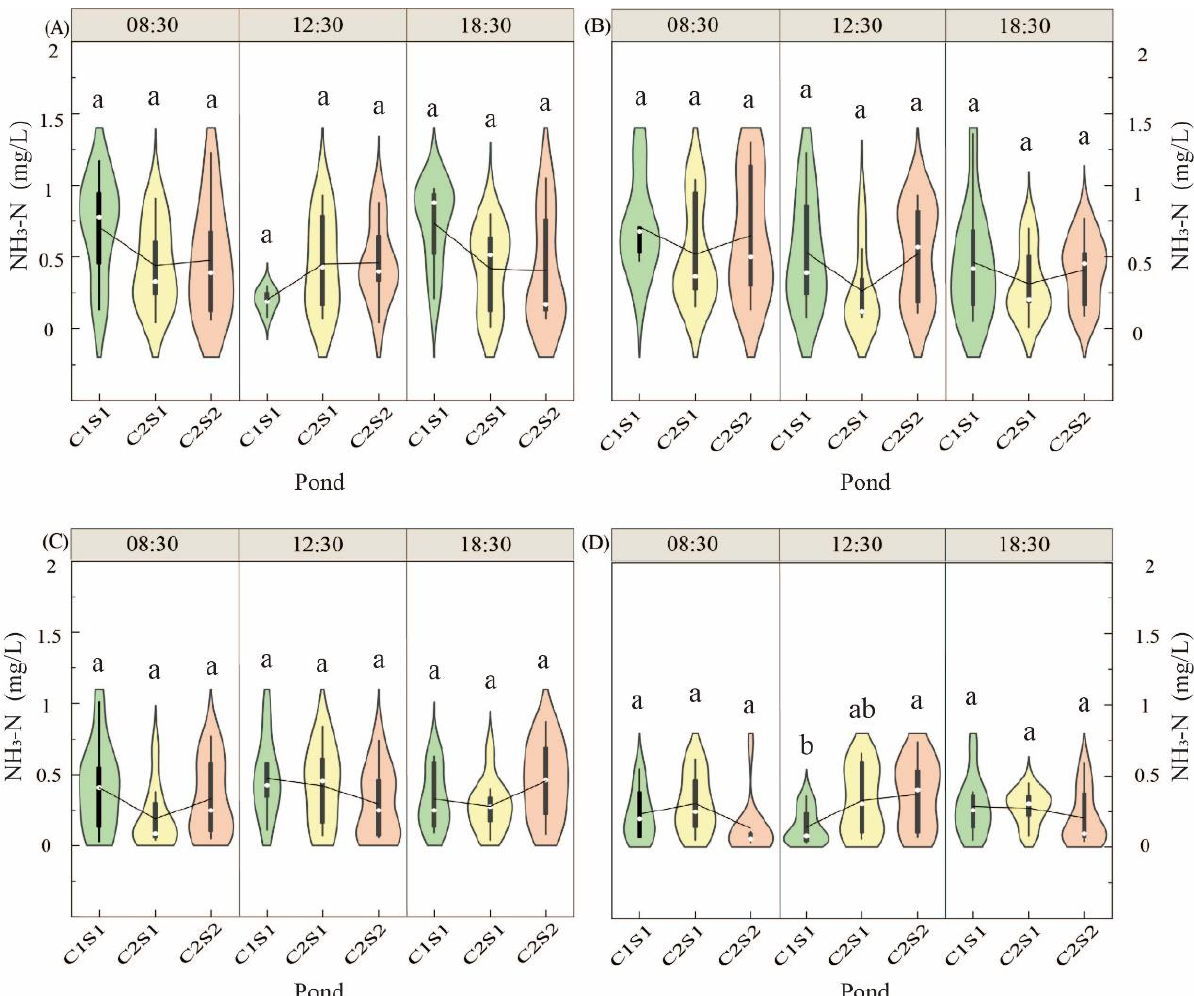
Figure 4. Monthly variation of water ammonium-nitrogen (NH 3 -N) in different ponds. ( A ) July; ( B ) August; ( C ) September; ( D ) October. Values with the same letter are not significantly different (LSD post hoc test).